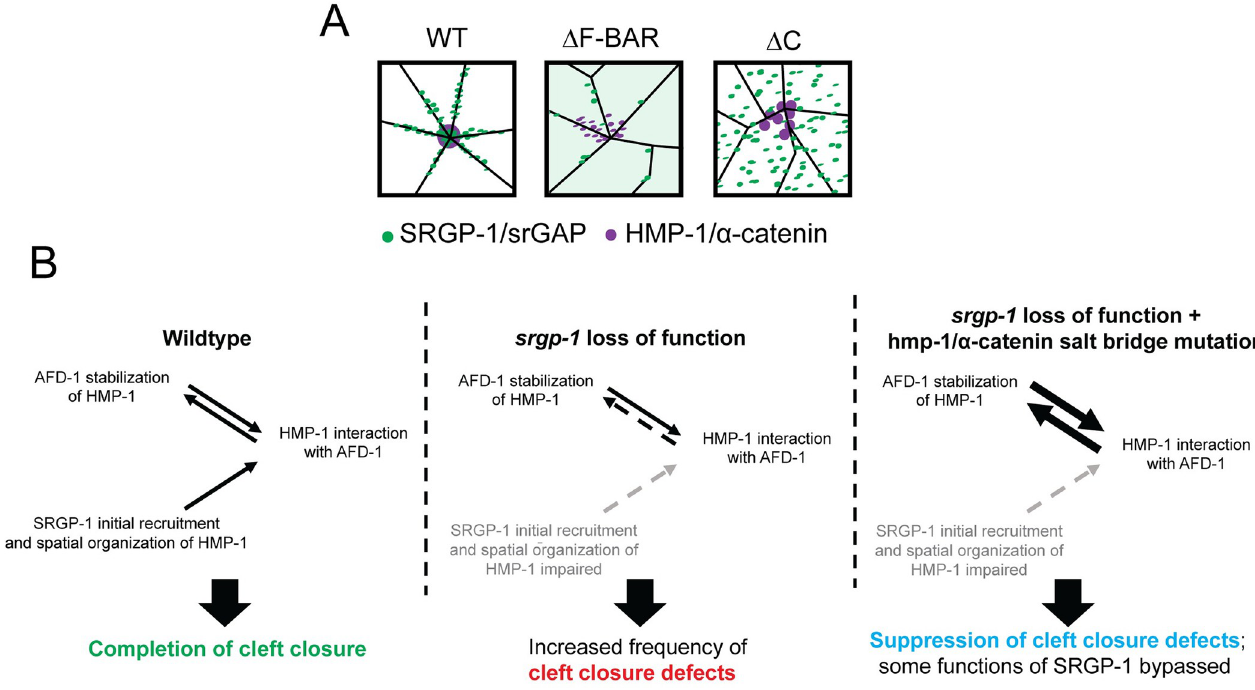
Fig 7. Summary of the roles of SRGP-1/srGAP and AFD-1/afadin in stabilizing HMP-1/ α -catenin at rosettes. (A) Visual summary of HMP-1 and SRGP-1 distribution in cells in different srgp-1 mutant backgrounds. (B) Summary of proposed routes by which HMP-1 is stabilized in wild-type and srgp-1 W122Stop ; hmp-1 R551/554A backgrounds. (Left) In wild-type embryos, SRGP-1 and AFD-1 function in different ways to modulate HMP-1 during cleft closure. SRGP-1 may aid rapid recruitment and spatial organization of HMP-1 at sites of high membrane curvature in rosettes. AFD-1 may be recruited to cell-cell contacts at the ventral cleft independently of HMP-1. Once there, however, it may reciprocally stabilize HMP-1 at cell-cell contacts (two-way arrows). (Middle) When SRGP-1 function is impaired, initial recruitement and/or spatial organization at rosettes is impaired. This leads to reduced interactions of HMP-1 and AFD-1 (dashed arrow). (Right) When HMP-1 is activated by introducing salt bridge mutations it may be able to bypass SRGP-1 requirements, possibly via enhanced interaction with AFD-1 (bold two-way arrows).